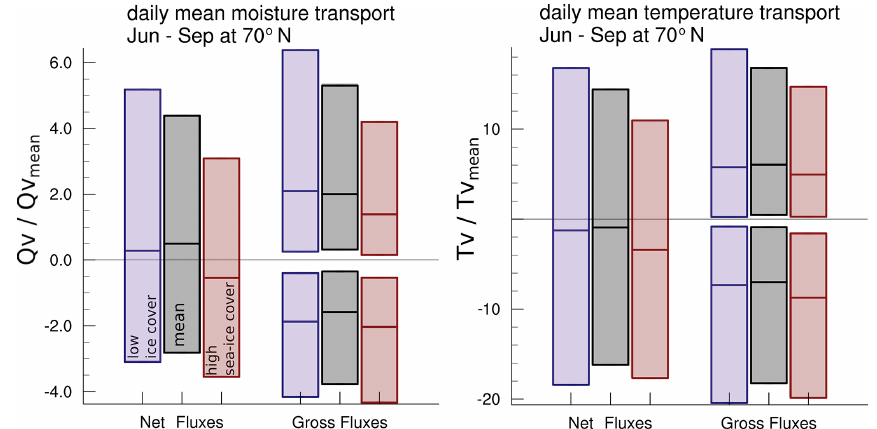
Figure 6. Meridional heat (Tv) and moisture (Qv) fluxes through a transect at the southern border of the area of interest (70 ◦ N). Fluxes were divided by the mean flow through each grid cell over all years. Low-sea-ice-cover years are shown in purple, all years are shown in grey and high-sea-ice-cover years are shown in red . 70 ◦ N lies just south of the coastline on land. We divide the fluxes into net (spatial mean over all data points at the 70 ◦ N edge) and gross (spatial mean over all positive/negative data points at 70 ◦ N boundary). Indicated are the median (center bar) as well as the first and third quantile of the distribution. For minima and maxima, see Table